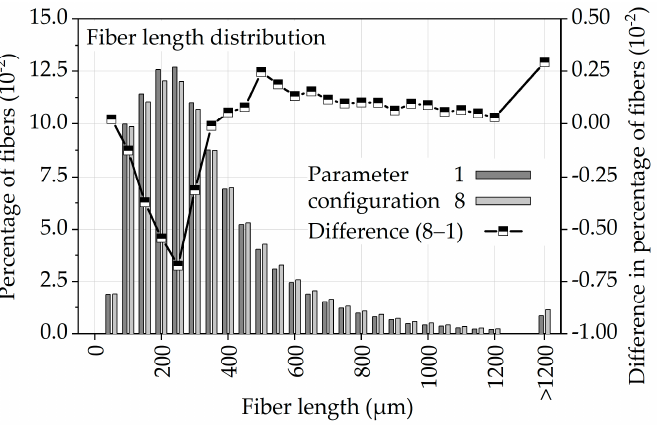
Figure 14. Normalized fiber length distribution of specimens with parameter configurations 1 and 8.